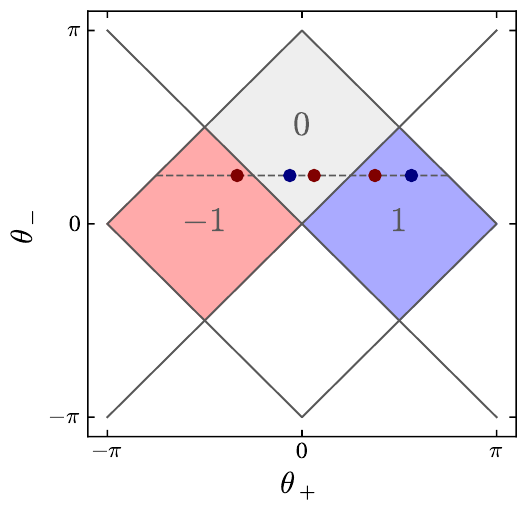
Figure 1: Topological index (charge) as a function of ( θ + , θ − ) ; dots are for typical numerical parameters used: θ − = π/ 4 (dashed line), θ + = − π/ 3, π/ 16,3 π/ 8 (for x > 0, red points), sweeping regions of charge c = − 1,0,1, respectively, and θ + = − π/ 16,9 π/ 16 (for x < 0, blue points), corresponding to the charges c = 0,1. The solid lines separates parameter regions with different